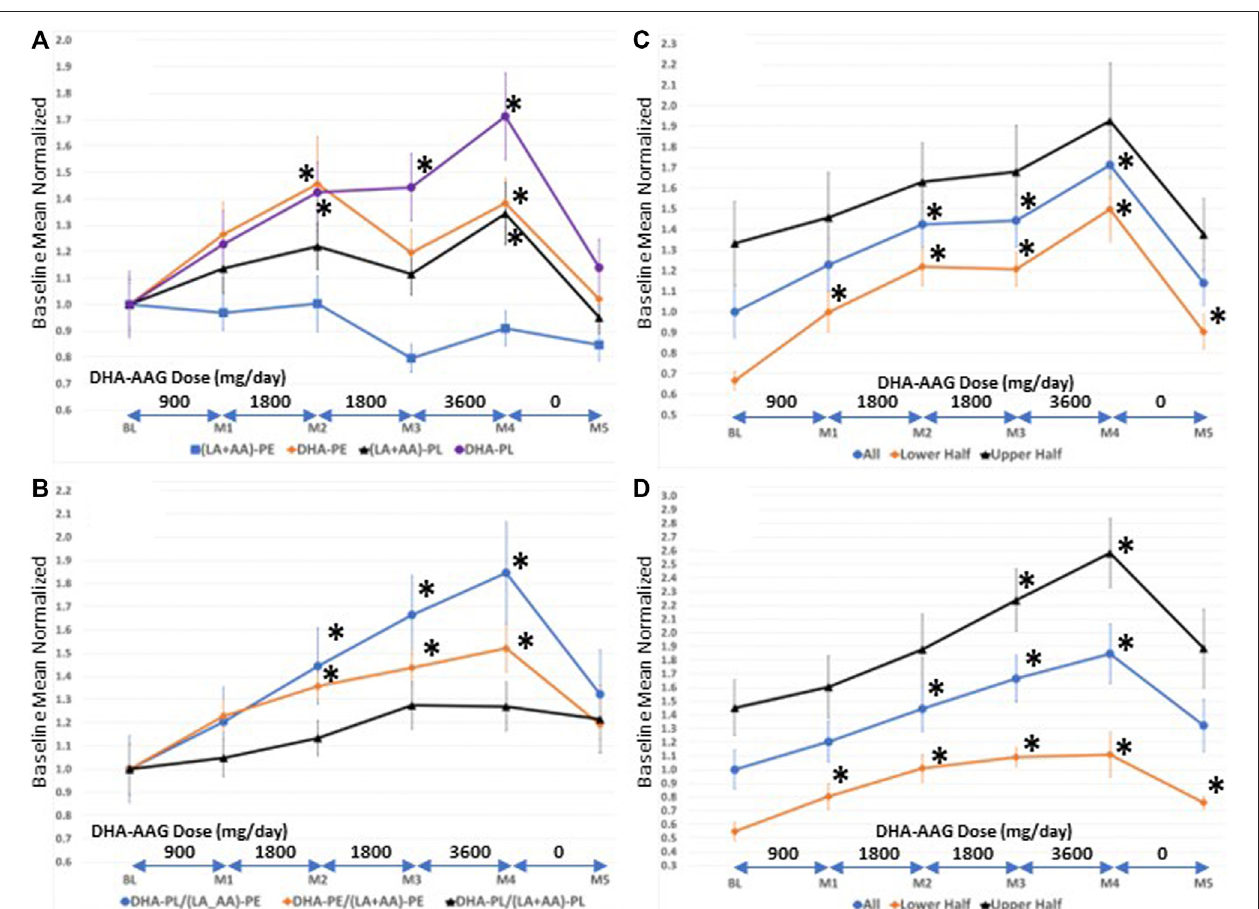
FIGURE 1 | (A) -Serum levels of direct (DHA-PL), indirect (DHA-PE (LA + AA)-PL), and non ((LA + AA)-PE) target phospholipid species (B) -serum levels of selected phospholipid ratios (C) -serum levels of DHA-PL in persons with high versus low baseline DHA-PL/(LA + AA)-PE levels. Values are means ± SEM.*, p < 0.05 versus baseline, student ’ s t-test